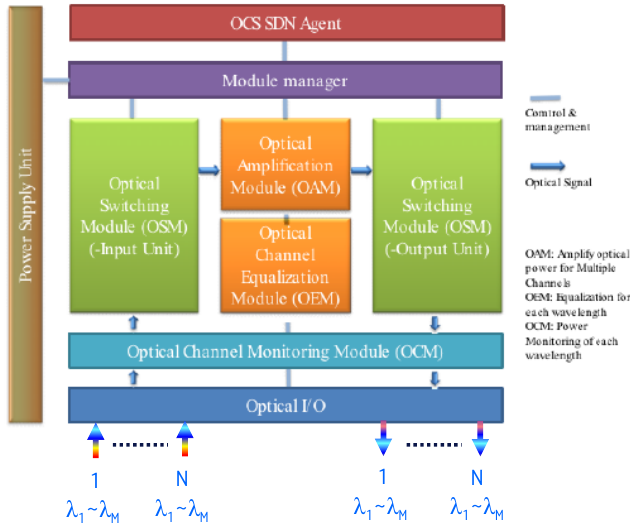
Figure 1. Architecture of the wavelength selective switch.